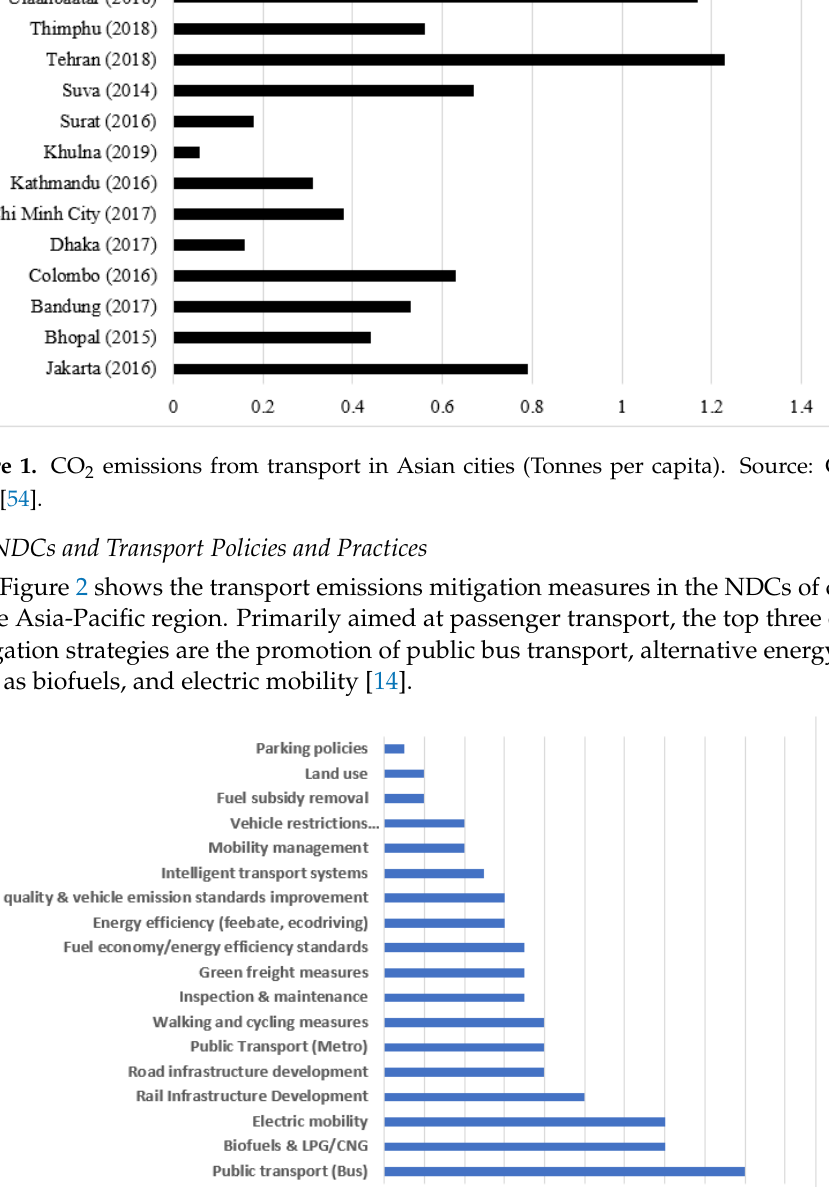
Table 3. Mitigation targets and transport mitigation strategies in selected NDCs. “Avoid–Shift – Improve” framework, development of mass rapid transit (MRT) and bus rapid transit (BRT), energy efficient rail lo- comotives